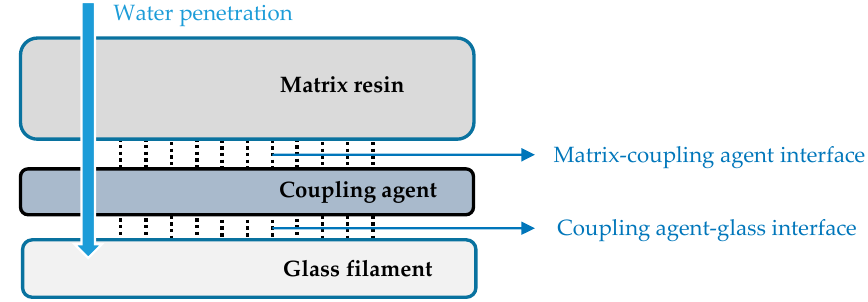
Figure 5. Water impact on various elements of the glass-PTFE fabric.